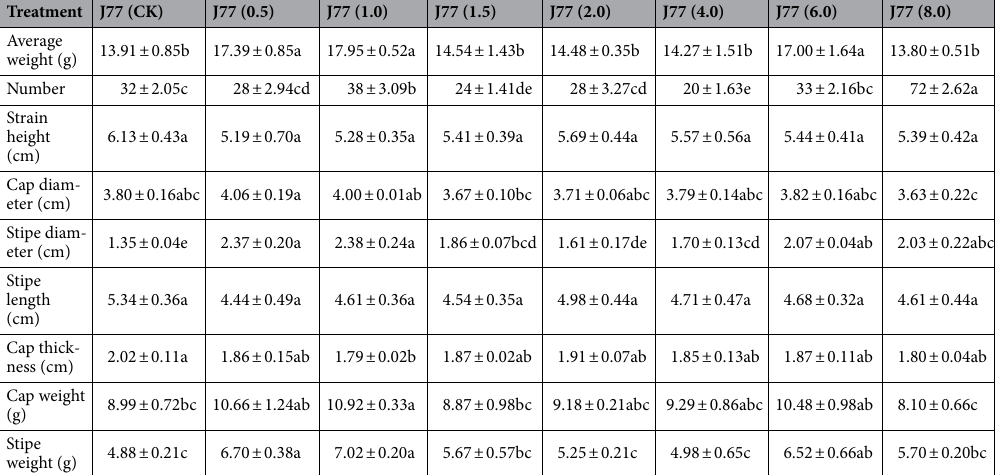
Table 2. Effects of different concentrations of cadmium stress on the agronomic characters of J77. Different lowercase letters in the same column indicate significant difference (p < 0.05).